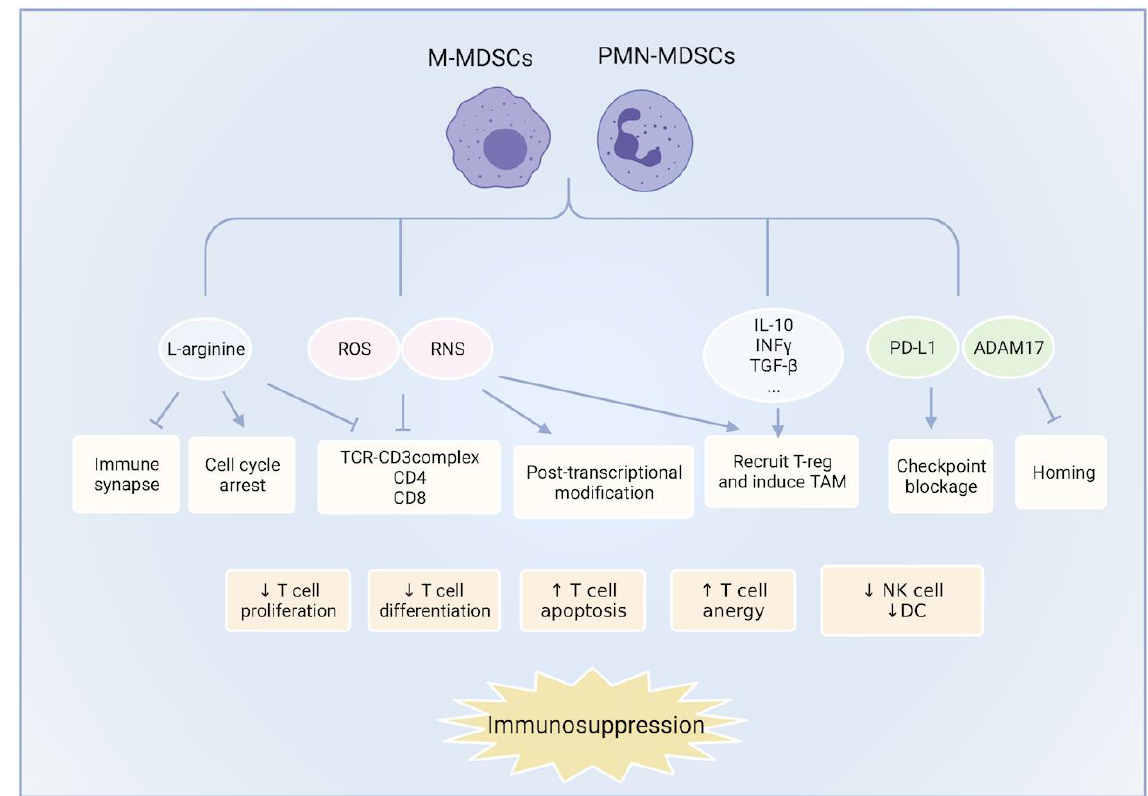
Figure 1. The mechanisms of MDSCs suppress the immune microenvironment: MDSCs execute potent immunosuppressive effects through various mechanisms, including nutrient depletion, oxidative stress, immunosuppressive cell induction, and the expression of PD-L1, AMAD17, and other molecules. These effects inhibit the proliferation and activation of effector cells, such as T cells, NK cells, and DC cells, and promote their apoptosis and anergy, contributing to the formation of an immunosuppressive microenvironment ultimately. The induction of Treg and TAM has also participated in this process. ROS: reactive oxygen; RNS: reactive nitrogen species; Treg: Regulatory T cells; TAM: tumor-associated macrophages; ADAM17: Adisintegrin and metalloproteinase 17; DC: dendritic cell.